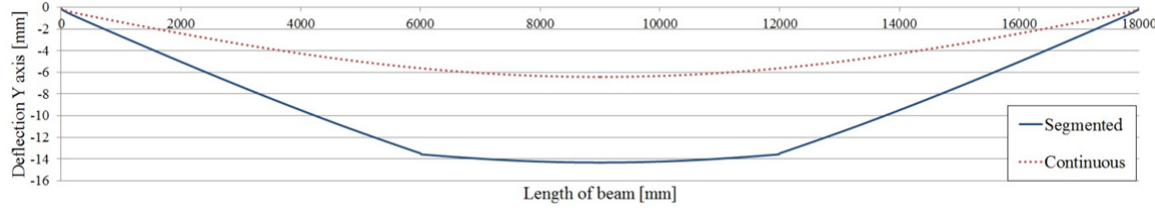
Fig. 8 Vertical displacement of a continuous and the segmented beam.